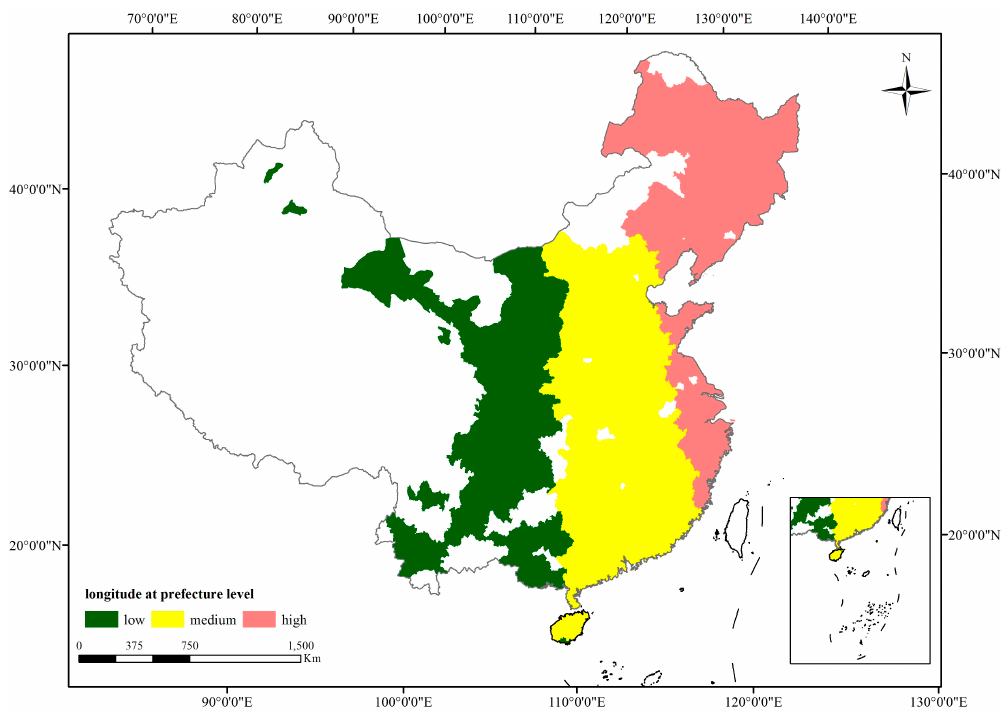
Figure A2. Classifications based on longitude at prefecture level.